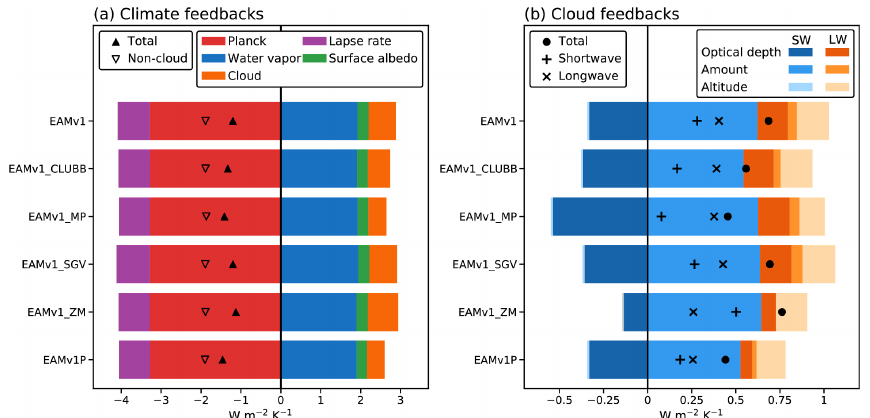
Figure 18. (a) Climate feedbacks and (b) cloud feedbacks decomposed using radiative kernels (Pendergrass et al., 2018; Zelinka et al., 2012b, a,